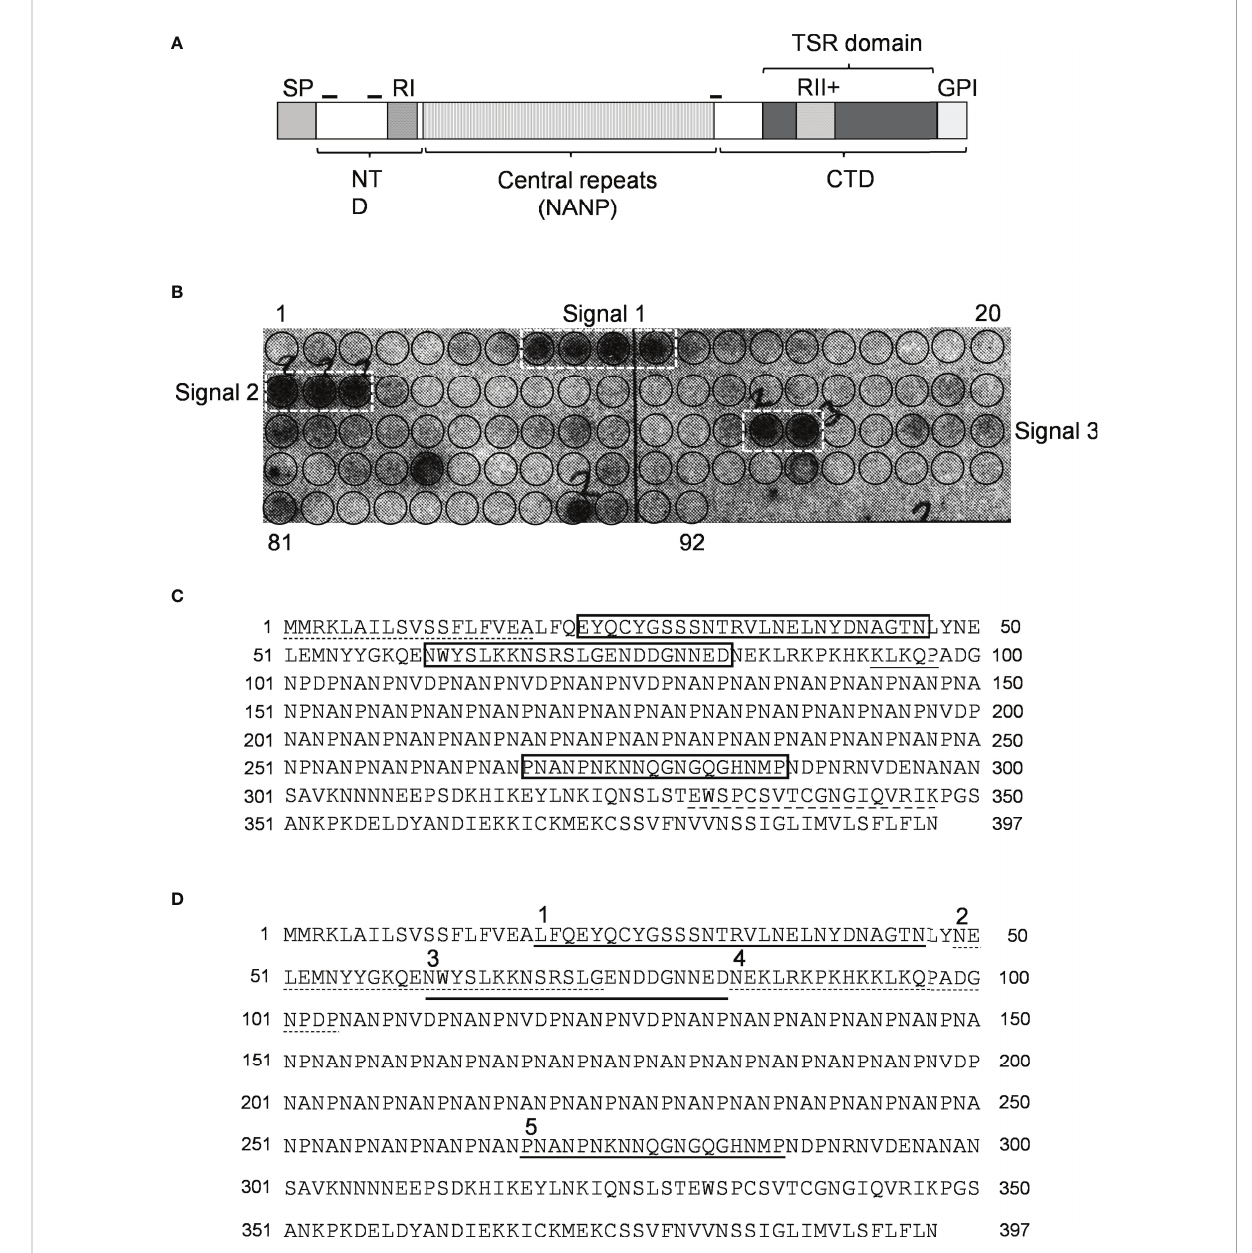
FIGURE 2 Binding of C4bp to CSP peptides. (A) Schematic representation of P. falciparum CSP. SP, signal peptide; NTD, N-terminal domain; CTD, C- terminal domain; RI, region I; RII+, region II plus; GPI, GPI anchor sequence; hyphen symbols denote locations of C4bp binding signals. (B) PepSpot membrane showing C4bp binding signals to CSP peptides. Circles drawn on membrane indicates locations of the 92 overlapping peptides. (C) C4bp binding signals delineated by rectangles on the CSP amino acid sequence. Dash, single, and dash long line under speci fi c amino acid sequences indicates SP, RI and RII+ regions, respectively. (D) Synthesized biotinylated CSP peptides delineated on the FL-CSP polypeptide sequence. Number 1, 3, and 5 above the sequence denote Pep1, 3, and 5 that showed binding to C4bp in the PepSpot assay, respectively, and number 2 and 4 denote the control peptides Pep2 and 4,